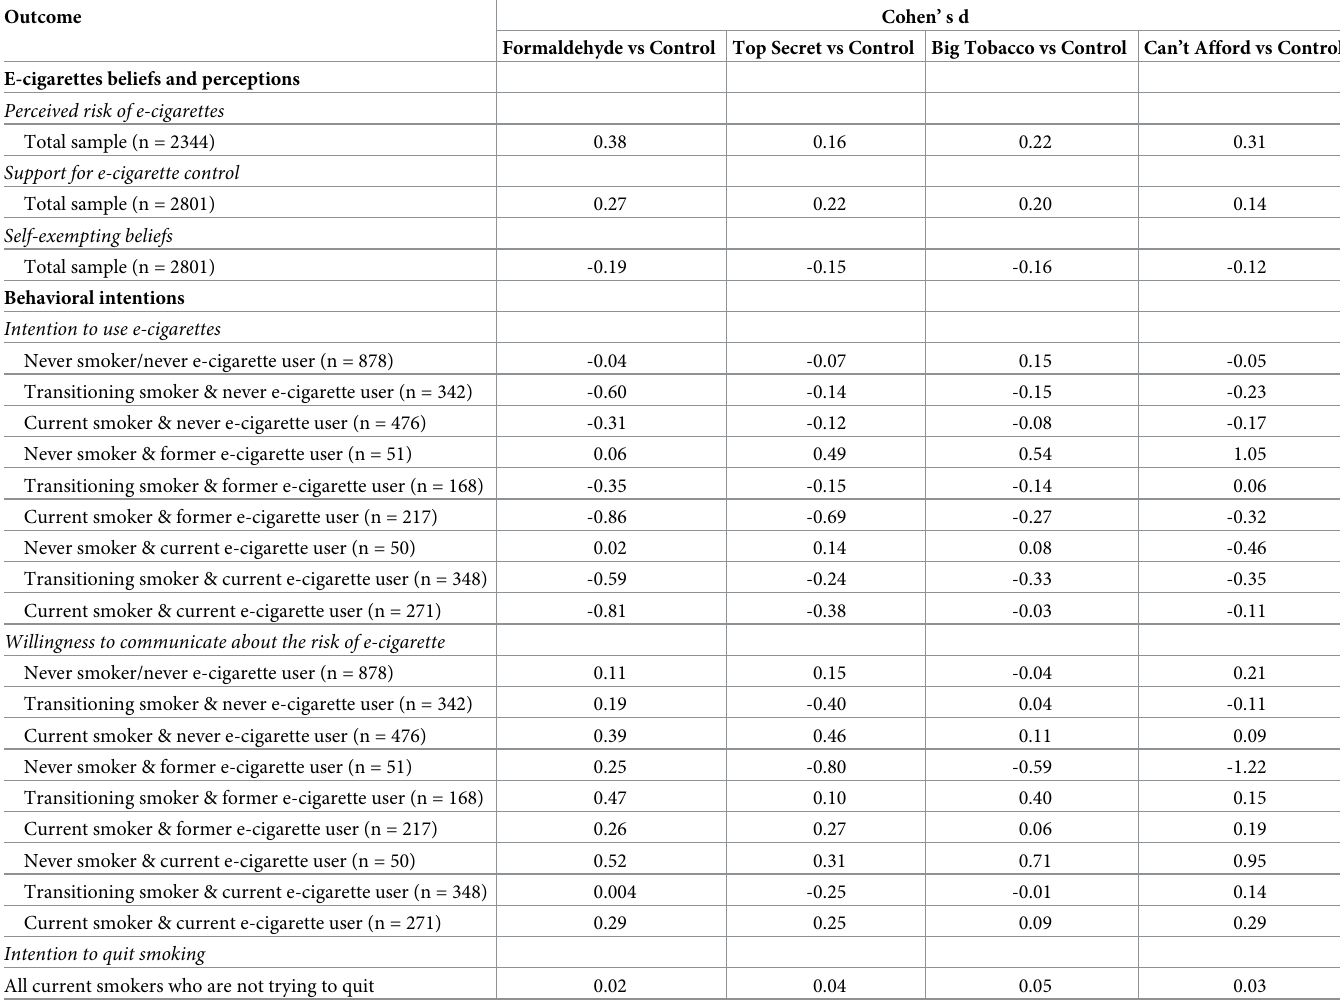
Table 4. Impact of condition on dependent variables in the total sample and by smoking and e-cigarette use status—Cohen’s d effect size.